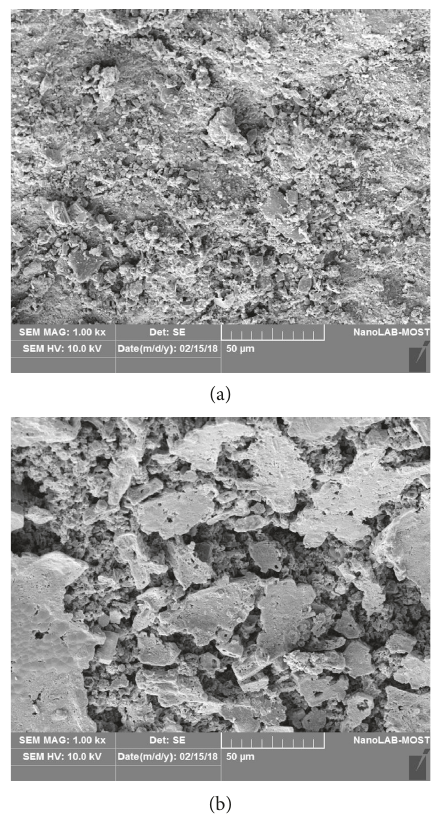
Figure 6: SEM images of the aggregates. (a) VA; (b)